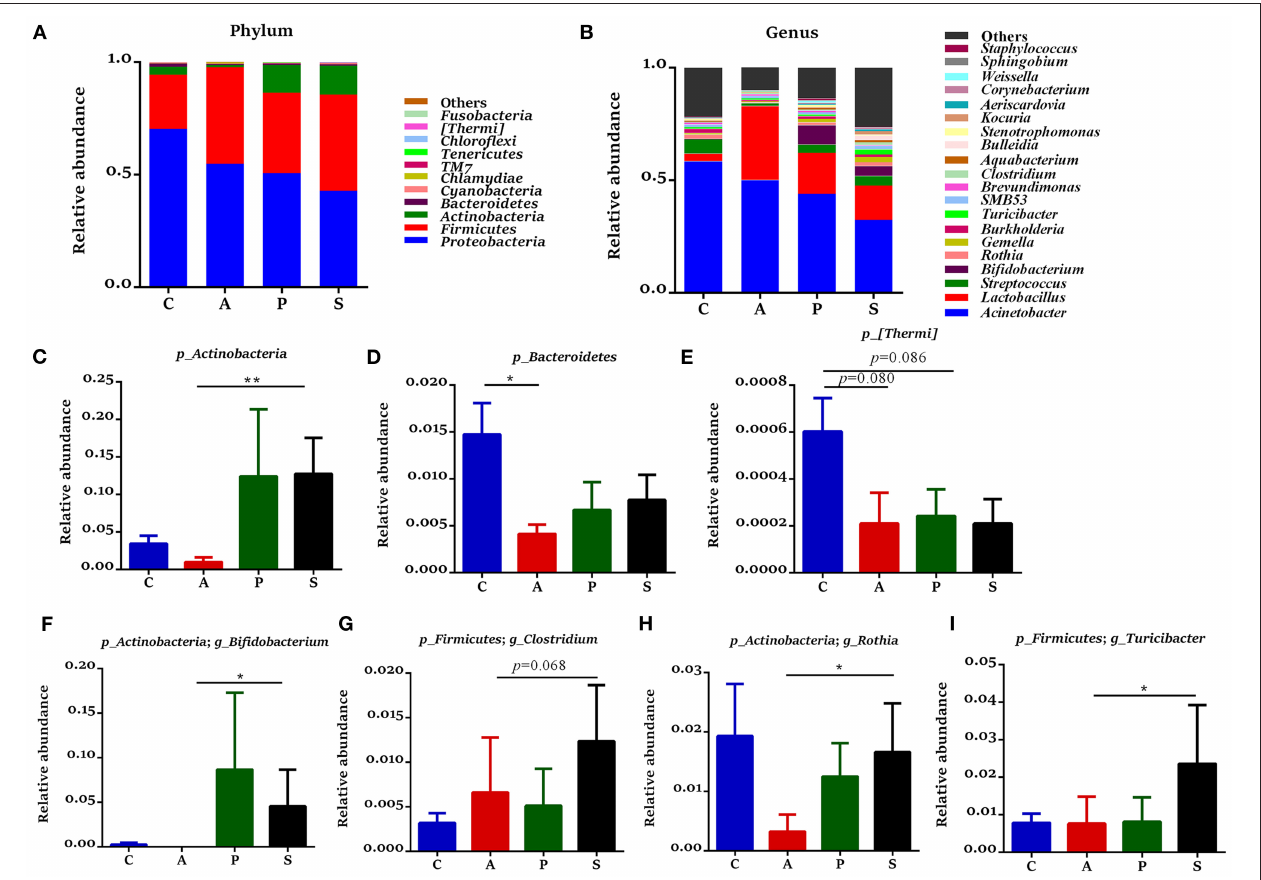
FIGURE 6 | Gut microbiota community composition in the jejunum of offspring piglets. Abundances of the jejunal microbiota at (A) phylum and (B) genus levels of offspring piglets. All phyla and the top 20 genera were listed. Comparison of relative abundances at (C–E) phylum and (F–I) genus levels were analyzed by the Kruskal-Wallis rank-sum test. * P < 0.05; ** P < 0.01. C, control group; A, antibiotic group; P, probiotic group; and S, synbiotic